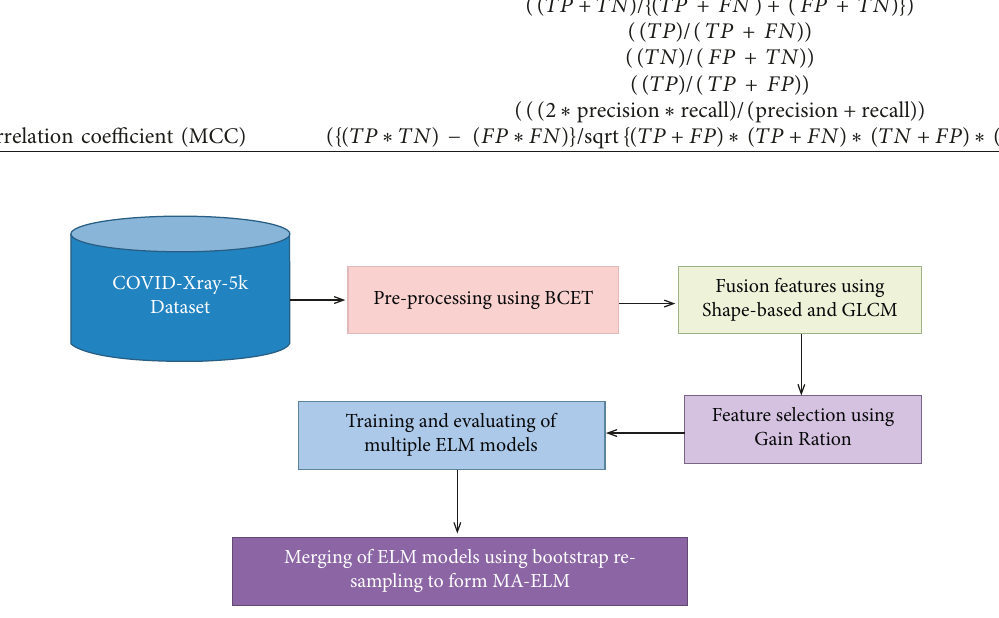
Figure 3: Experimental research